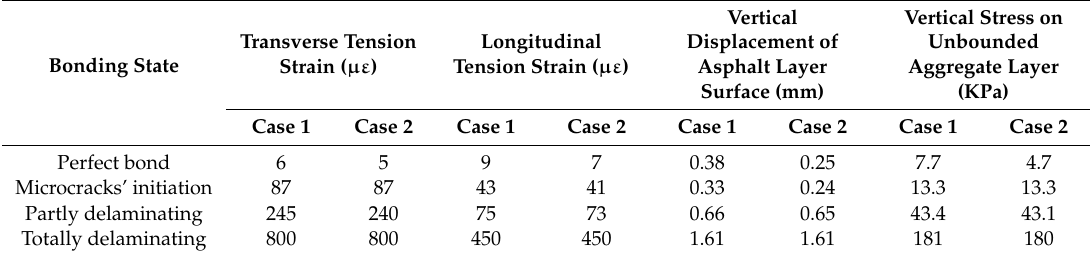
Table 8. Dynamic characteristics of four interfacial bonding